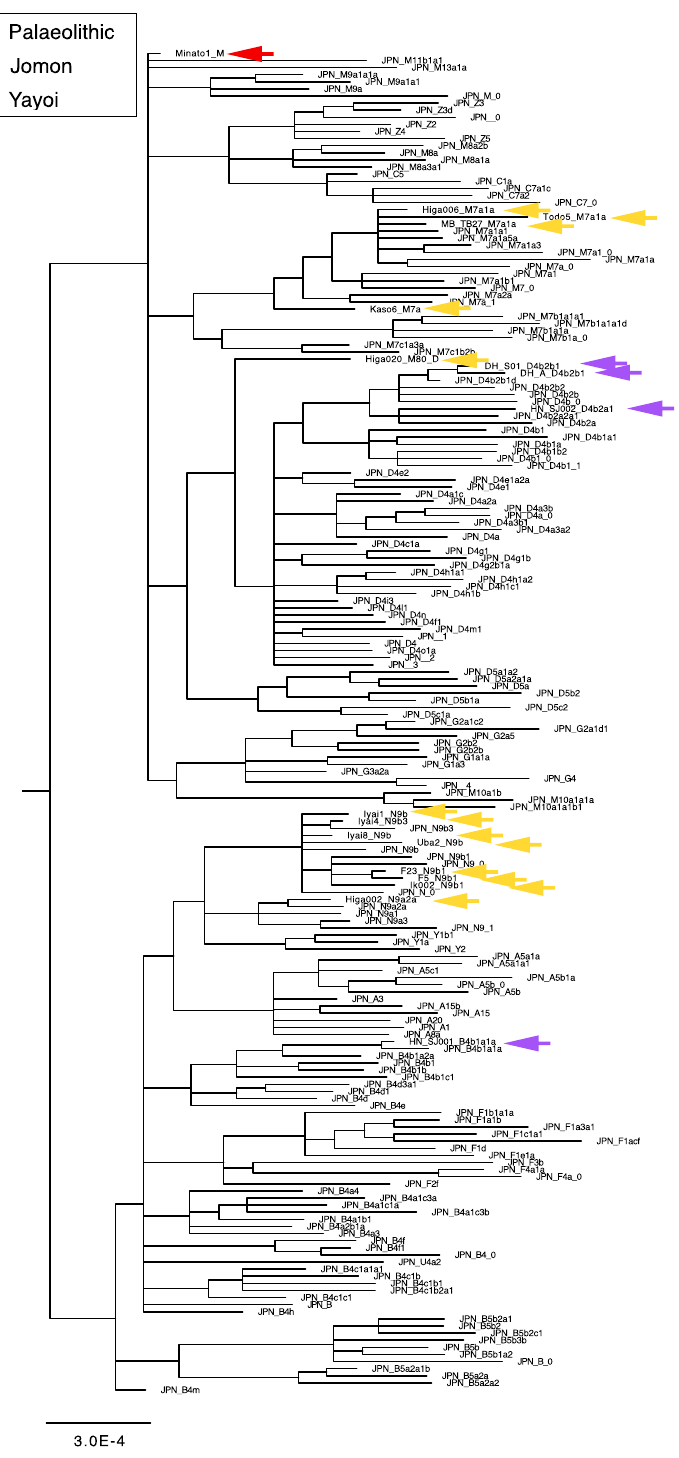
Figure 2. Bayesian phylogenetic tree of complete mitogenome sequences of 18 ancient and 171 present-day individuals in the Japanese Archipelago. Coloured arrows show the positions of ancient individuals; red, yellow, and purple for Palaeolithic, Jomon, and Yayoi, respectively. The tree was rooted with mitogenome haplogroup L0a (accession number: EF184601.1). The estimated haplogroups for newly determined ancient samples are Minato1:M, Iyai1:N9b, Iyai4:N9b3, Iyai8:N9b, Higa002:N9a2a, Higa006:M7a1a, Higa020:M80’D, Todo5:M7a1a, Kaso6:M7a, Uba2:N9b, MB-TB27:M7a1a, DH-S01:D4b2b1, DH-A:D4b2b1, HN-SJ001:B4b1a1a and HN-SJ002:D4b2a1, respectively (Table 1 and Supplementary Table